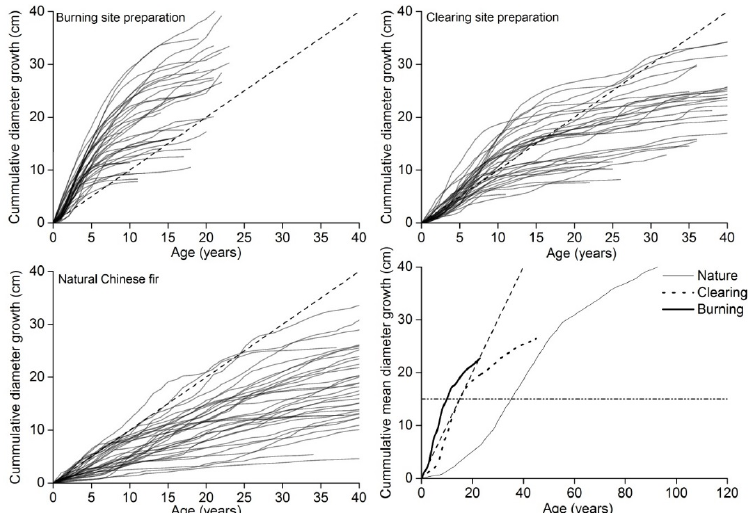
Figure 3. Individual diameter growth curves of Chinese fir at the three study areas. Mean diameter growth curves for the natural Chinese fir forest (solid line), the planted Chinese fir forest of the burning site (bold solid line) and the planted Chinese fir of the clearing site (dotted line). Dashed lines indicate a constant diameter growth of 1 cm per year. The dashed-dotted line represents the MCD. Note that individual diameter growth curves for the natural Chinese fir were truncated at 40 cm in the natural forest.